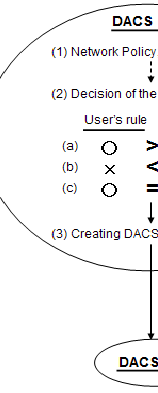
Figure 6 Creating the DACS rules on the DACS